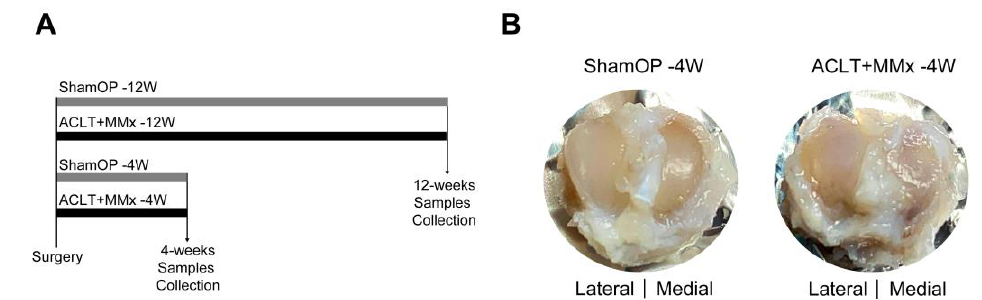
Figure 1. Experimental design and morphological changes of tibial cartilage. ( A ) The experimental design. ( B ) Microscopic images representing postsurgery of anterior cruciate ligament transection combined with medial meniscectomy (ACLT+MMx) method, with changes seen to tibial cartilage morphology compared with sham group (sham-OP) at the fourth week.